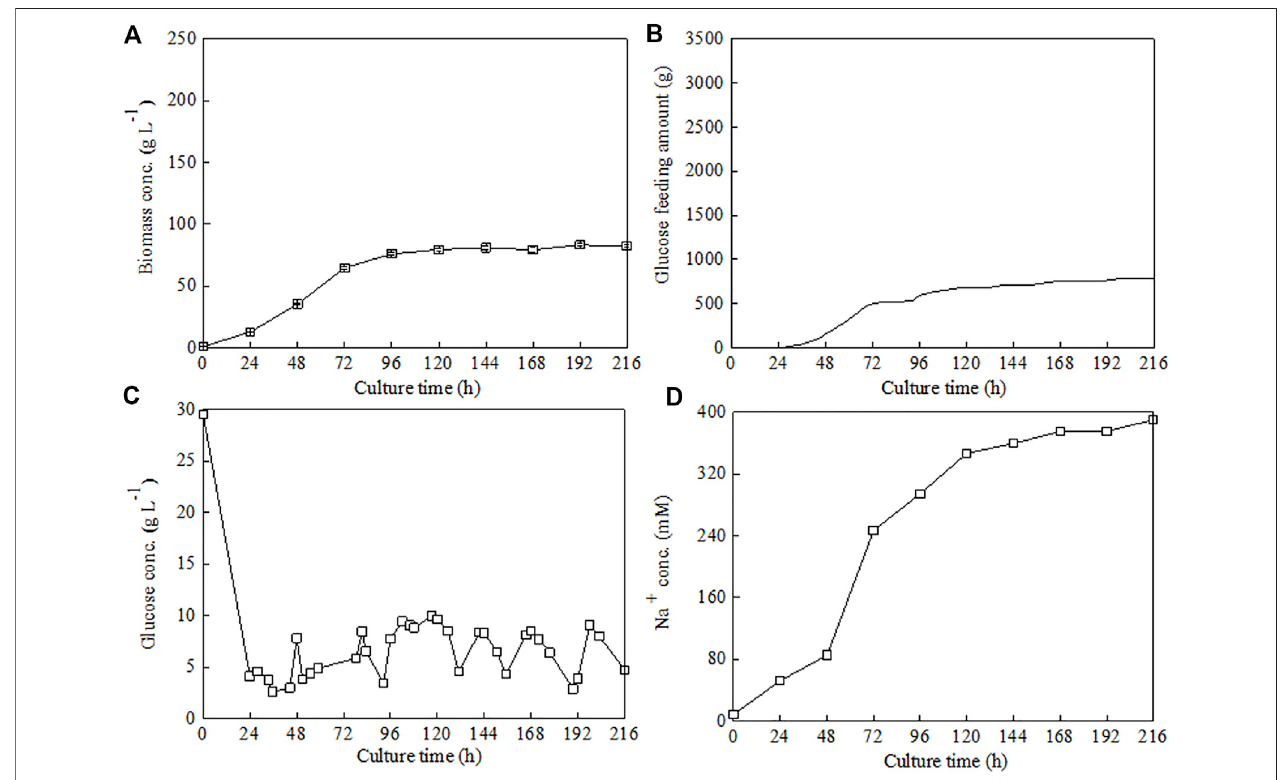
FIGURE 4 | Time courses of C. sorokiniana CMBB276 growth (A) , glucose consumption (B) , glucose concentration (C) , and Na + concentration (D) under fed- batch cultivation with ammonium chloride as nitrogen source in a 7.5-l fermenter. Sodium hydroxide solution was used for pH adjustment, and the C/N ratio of feeding medium was